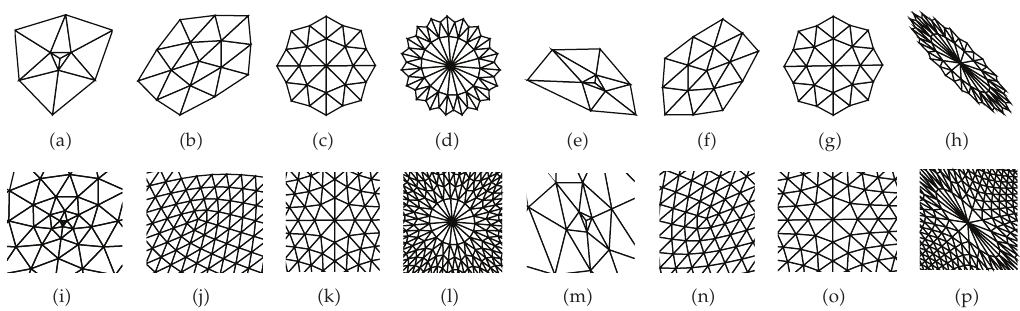
Figure 3: Visualization of characteristic maps: (cid:6) a (cid:7) – (cid:6) d (cid:7) control nets from the eigenvectors of M (cid:6) k (cid:7) with valences n (cid:8) 3 , 5 , 8 , 19, and f (cid:6) k (cid:7) (cid:8) 1 − 1 / 2 2 k − 1 ; (cid:6) e (cid:7) – (cid:6) h (cid:7) control nets with valences n (cid:8) 3 , 5 , 8 , 19, and f (cid:6) k (cid:7) (cid:8) cos (cid:6) π/ (cid:6) 2 k n (cid:7)(cid:7) ; (cid:6) i (cid:7) – (cid:6) p (cid:7) local regions around the irregular vertex of the characteristic maps after four subdivision